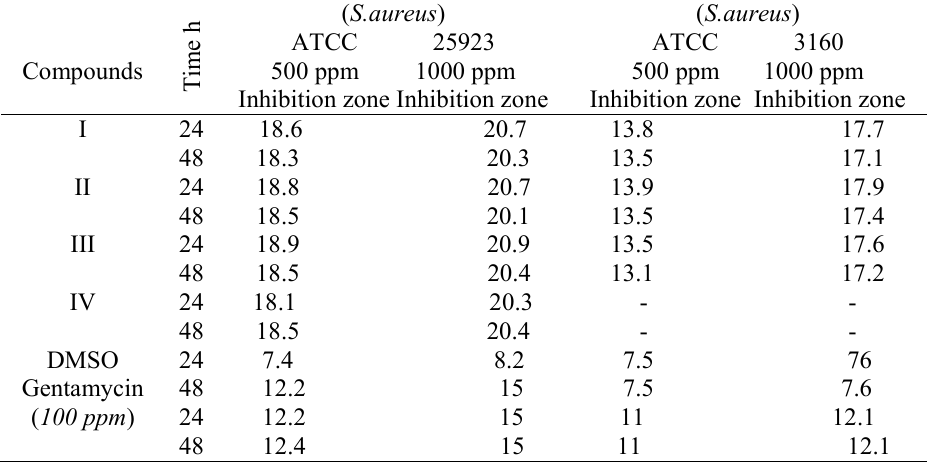
Table 1. Antibacterial activity of transition metal complexes against S. aureus.